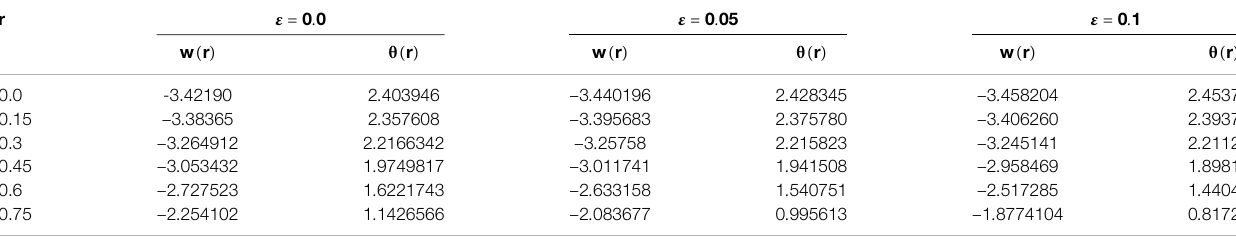
TABLE 2 | Numerical values of velocity and temperature distributions Vs. r against ε .